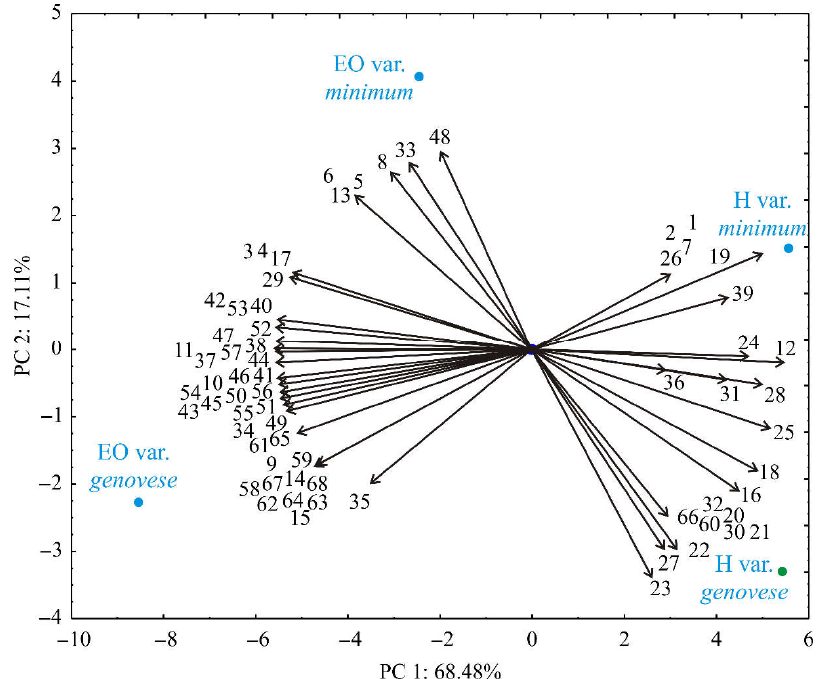
Figure 1. The PCA biplot diagram describes the relations between essential oil and hydrolate compounds of O. basilicum var. genovese and var. minimum (number codes in this figure present the compounds listed in Table 1), EO—essential oil; H—hydrolate.